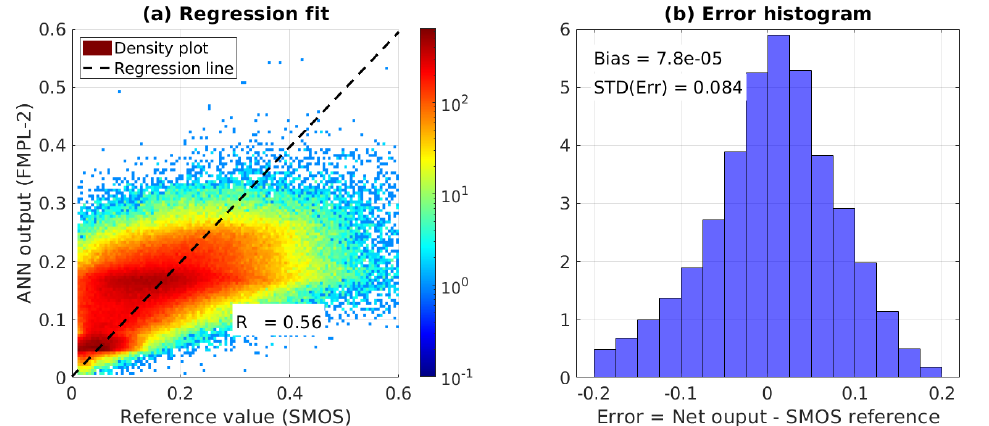
Figure 5. ( a ) Scatter-density plot between the ANN output using NDVI and skin temperature as input data and the SMOS SM product as the network reference value; and ( b ) the error histogram between the ANN output and the SMOS